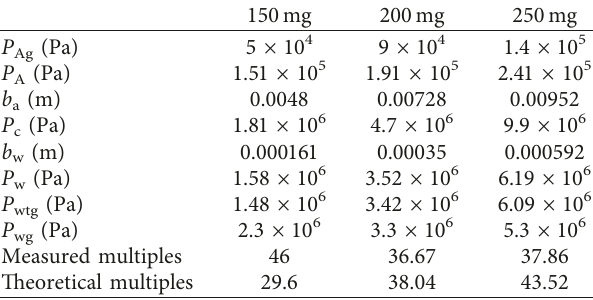
Table 3: Theoretical calculation